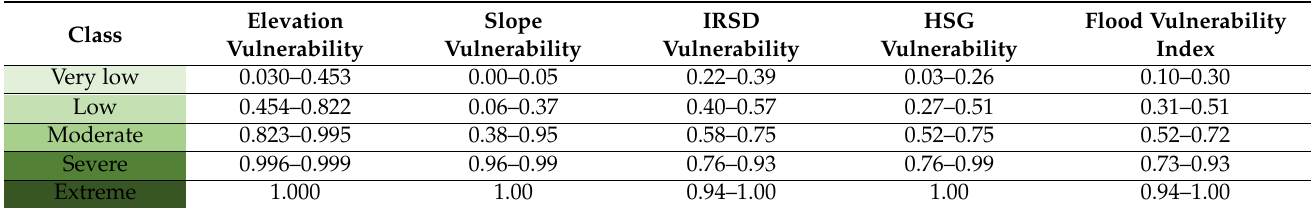
Table 4. Vulnerability classes applied to natural breaks produced by the Fuzzy Membership tool. Lighter green colours indicate very low and low Vulnerability, while darker colours represent severe and extreme